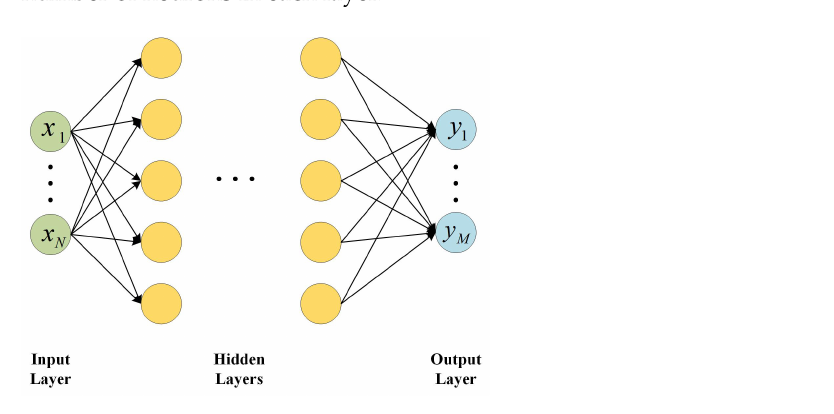
Figure 1. A basic schematic representation of DNN, which is composed of an input layer along with data x = [ x 1 , . . . , x N ] T ∈ R N , an output layer y = [ y 1 , . . . , y M ] T ∈ R M and hidden